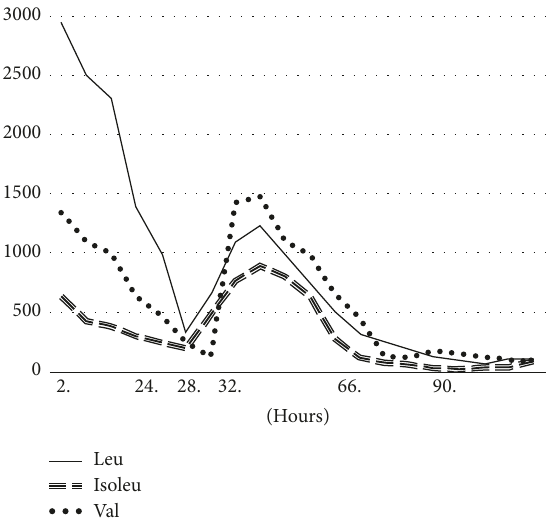
Figure 1: Hemodialysis and Na phenylacetate/benzoate and phenyl- butyrate treatment during attack management. 0–28 hrs: Contin- ious venovenous dialysis (through femoral vein) 28. hr: Cloggling of hemodialysis catheter, 32–66.hrs: Na phenylacetate/benzoate, 66. hrs+: Na phenylbutyrate (Pheburane (cid:2) 483 mg/gr,